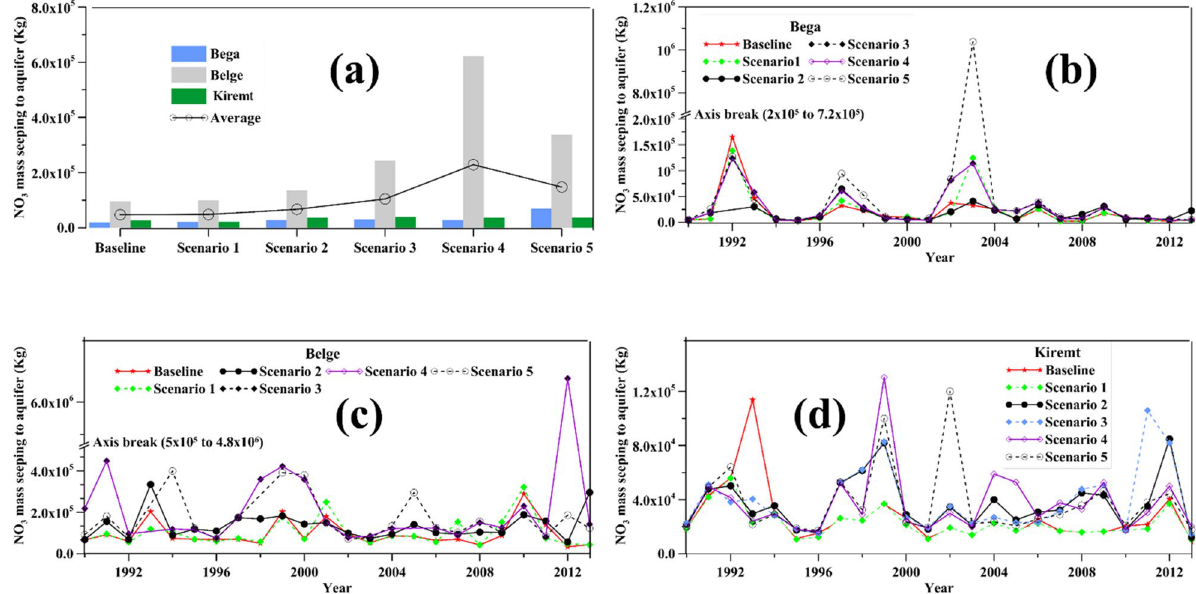
Figure 12. Temporal distribution of average nitrate (No3) seepage to aquifer: ( a ) comparison of average seasonal No3 seepage in each simulation scenario, ( b – d ) Seasonal No3 seepage from 1990 to 2013 under all simulation scenarios.